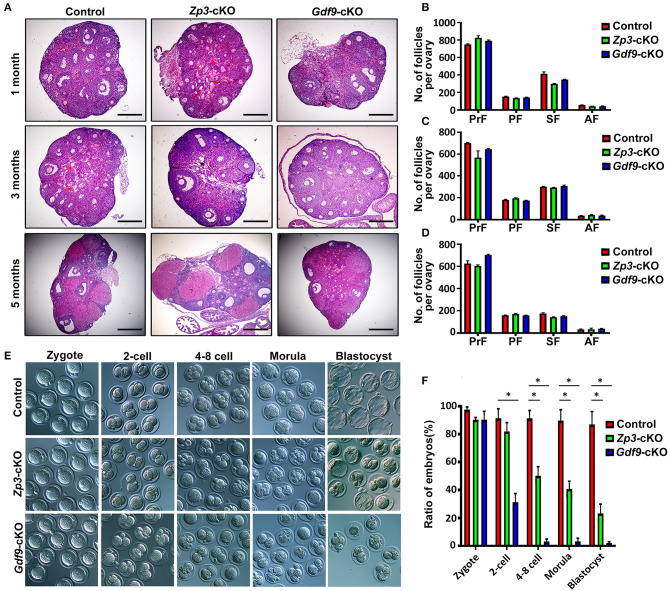
Conditional inactivation of Uhrf1 in either primordial or growing oocytes results in preimplantation embryo developmental arrest and female sterility in mice. (A) Histology of ovarian sections from control, Zp3-cKO, and Gdf9-cKO mice at 1, 3, and 5 months of age, respectively, stained with Hematoxylin and Eosin. Scale bars = 500 μm. (B–D) Quantitative analyses show the number of primordial follicles (PrF), primary follicles (PF), secondary follicles (SF), and antral follicles (AF) per ovary at the age of 1, 3, and 5 months, respectively. n = 3 for each genotype; data are presented as mean ± SEM. (E) Representative bright-field images show the morphology of the zygotes, two-cell embryos, four- to eight-cell embryos, morula, and blastocysts from control, Zp3-cKO, and Gdf9-cKO mice. (F) Statistical analysis of early embryos before implantation at each developmental stage. Data are presented as means ± SEM from three independent experiments. *p < 0.05.